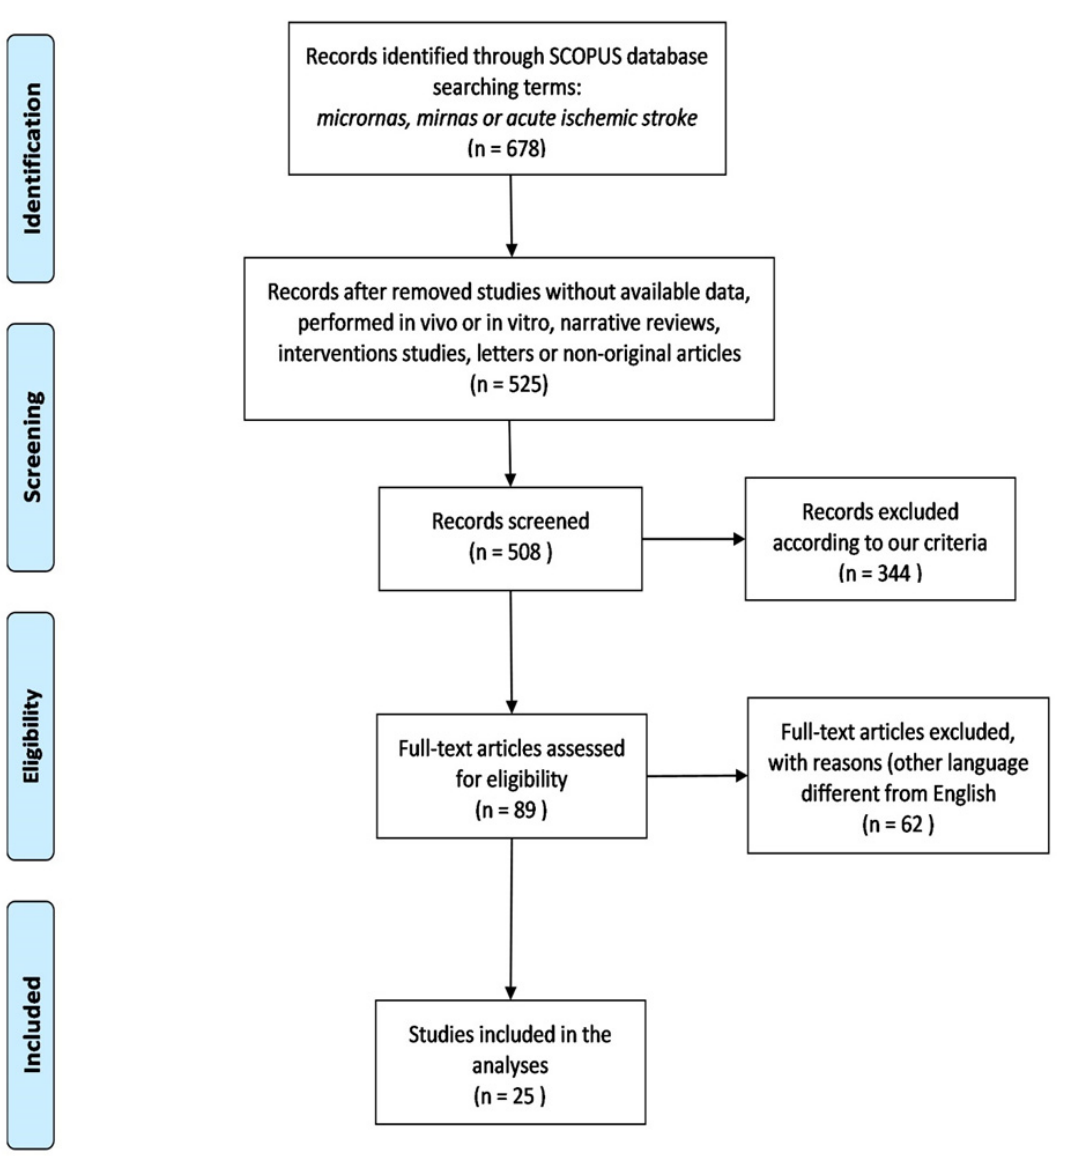
Figure 1. Flow diagram of the article selection for the meta-analysis, modified from Moher et al., 2009.